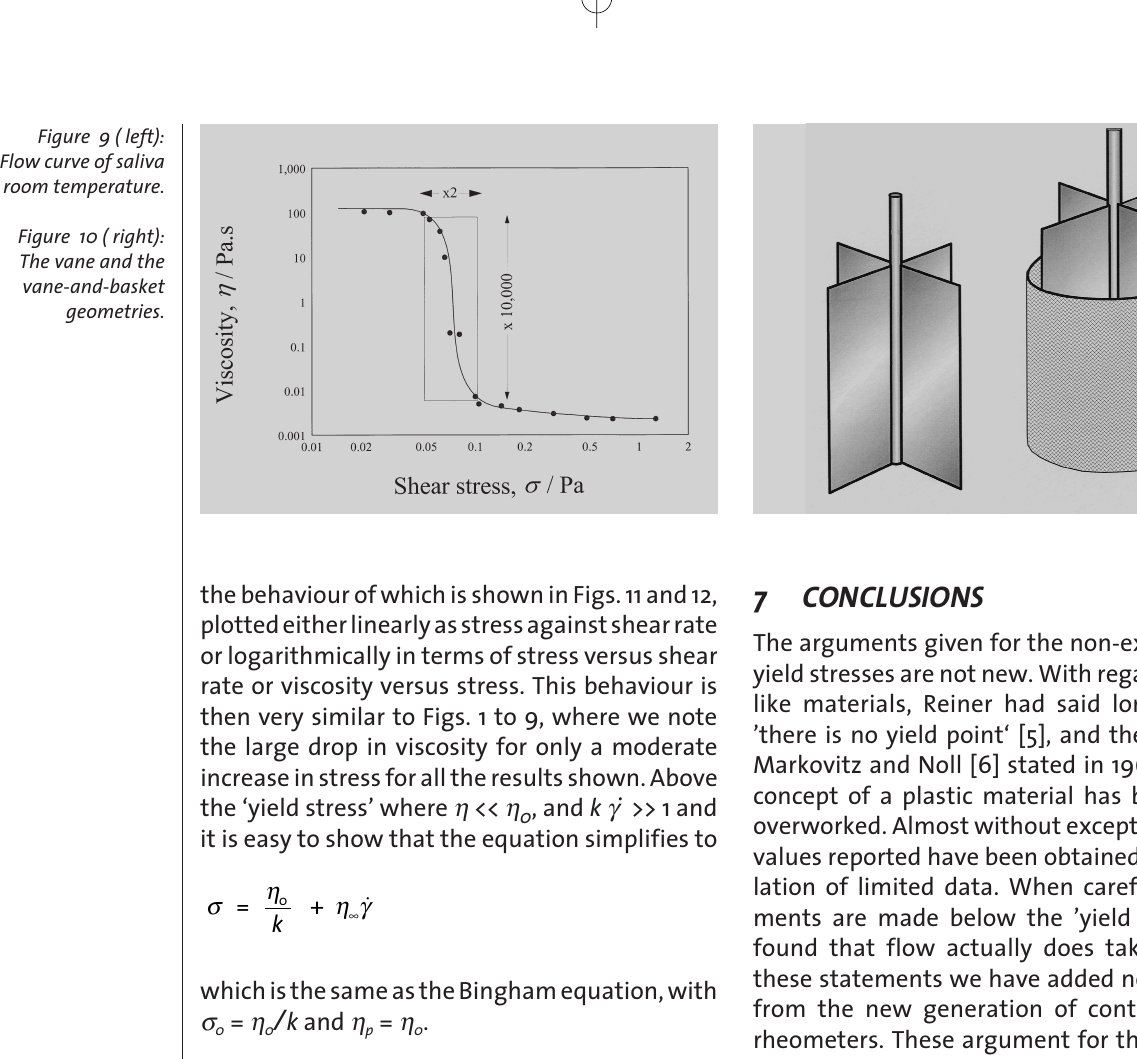
Figure 11: The Cross model with m=1 and typical values of the parameters, showing the apparent yield stress region and upper and lower Newtonian regions.